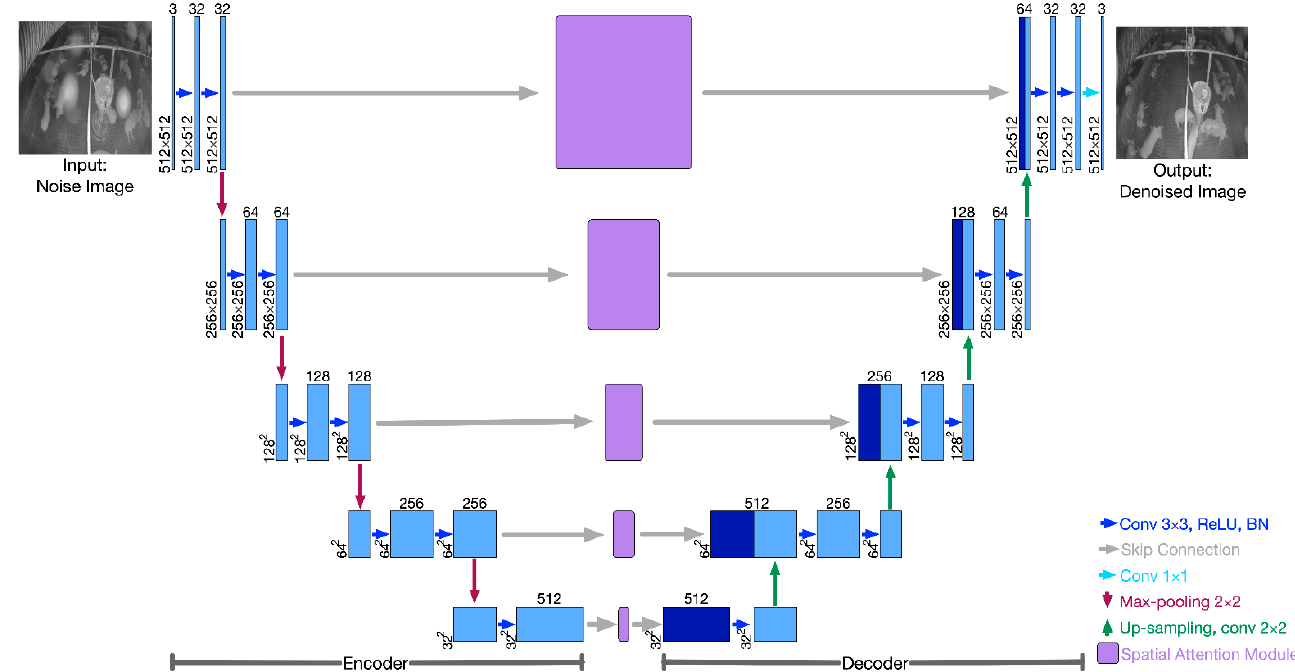
Figure 4. The Generator of the proposed model which consists of three parts: the encoder part, the attention module part, and the decoder